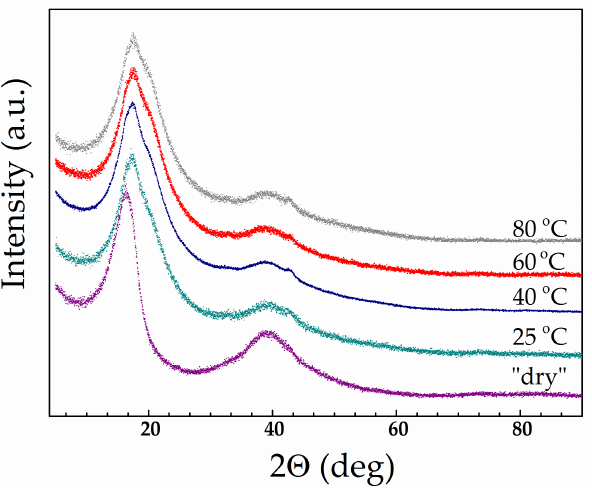
Figure 8. Wide-angle X-ray diffraction patterns for “dry” Li-Nafion and membrane samples swelled with EC/SL mixture with ω(SL) = 0.2 at different mixing temperatures specified in the figure.